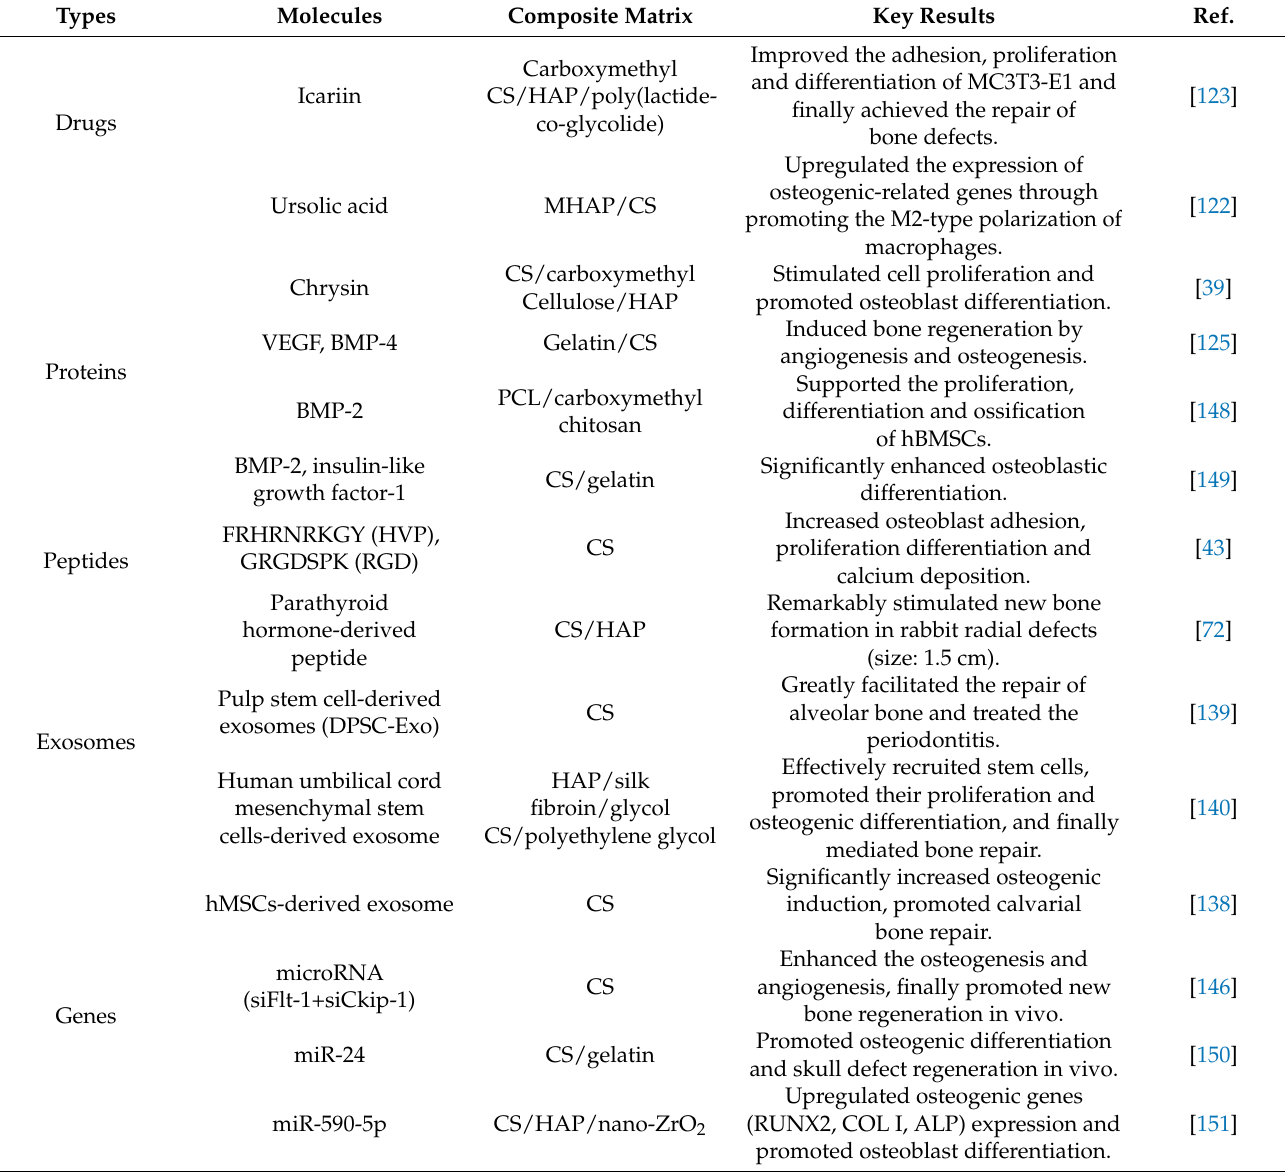
Table 2. The osteoinductive CS-based scaffolds integrate with different molecules. Key Results